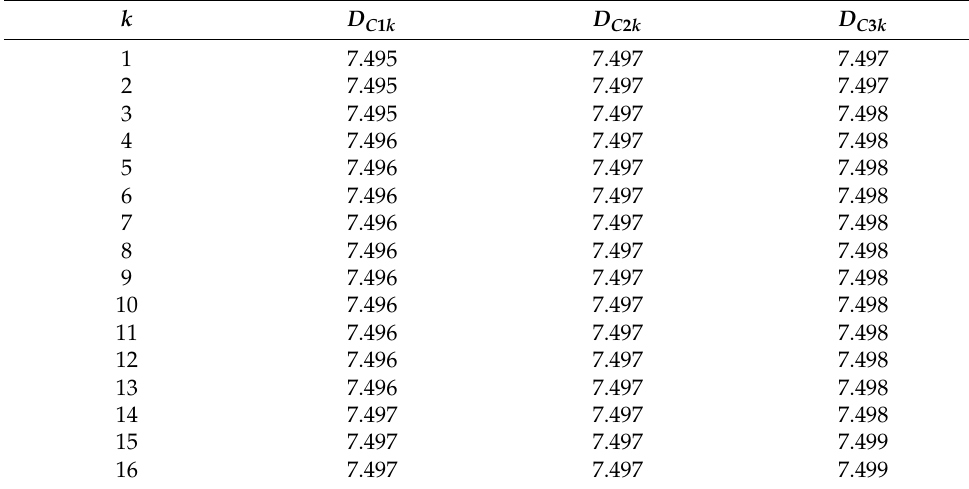
Table 5. Dimensions details of Part C in each